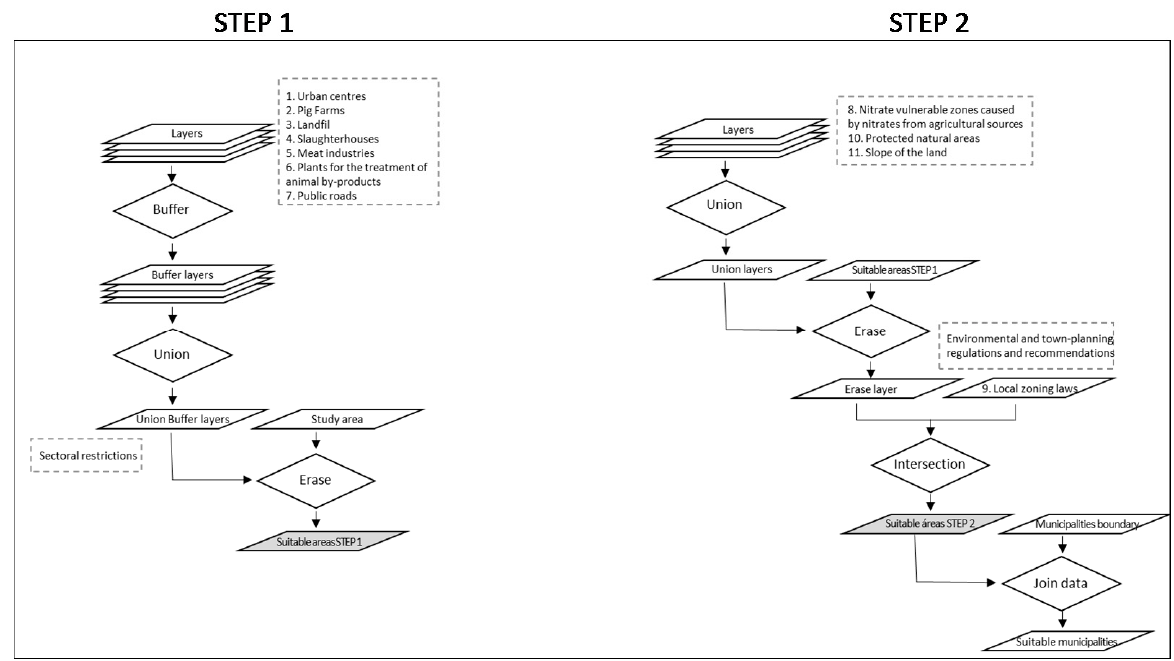
Figure 3. Geographical information (GIS) flowchart followed in STEP 1 and 2.